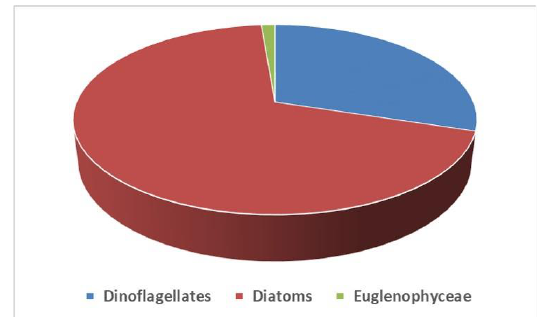
Figure 8 . Groups of